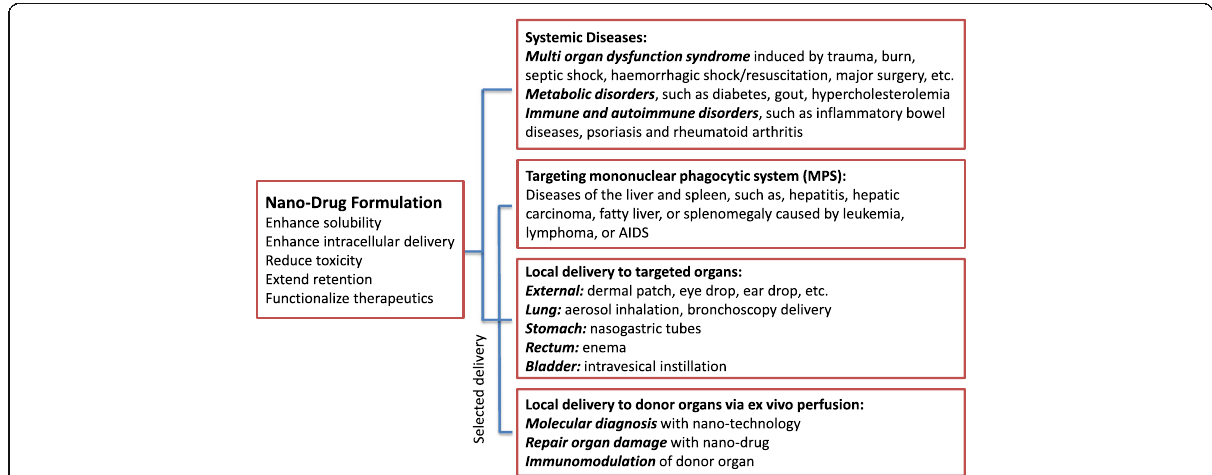
Fig. 1 New avenues for nanoparticle-related therapies. Potential application of nanodrug formulations for clinical situations less relies on passive enhanced permeability and retention (EPR)